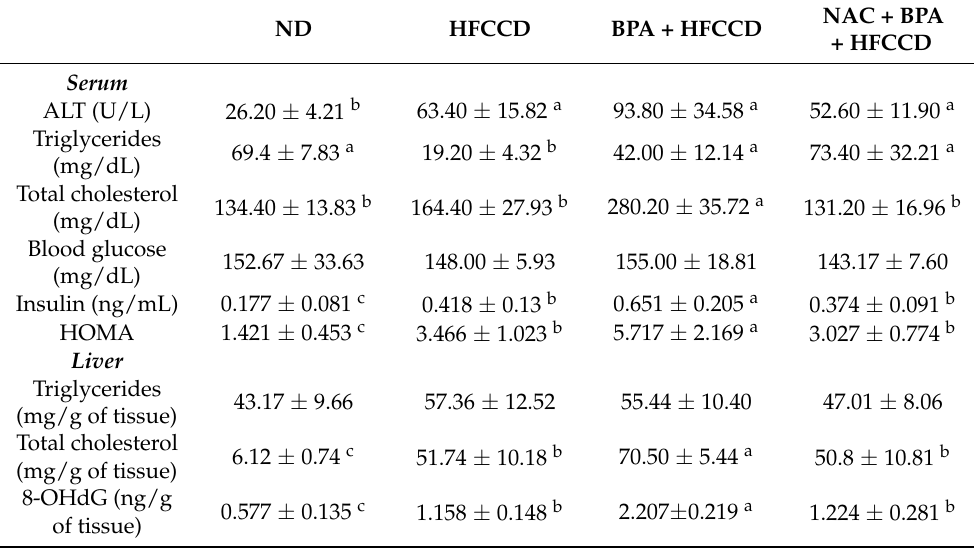
Table 2. Effects of BPA on blood and hepatic biochemical parameters in mice administered an HFCCD.